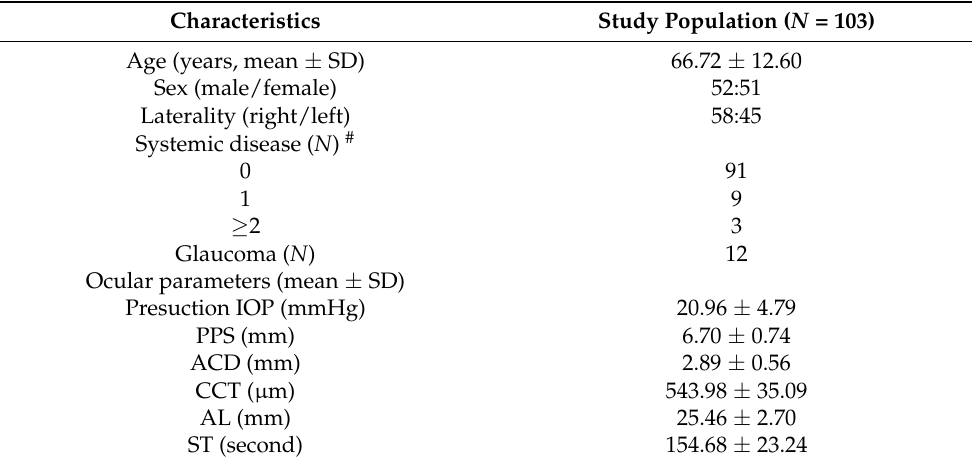
Table 1. Baseline characteristics of the study